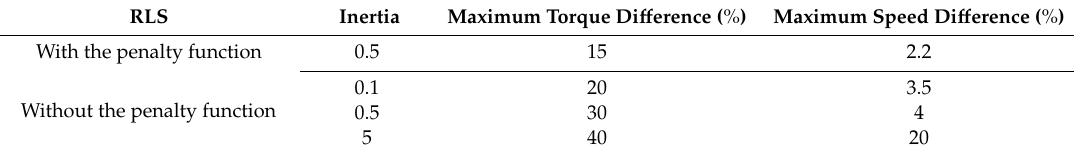
Table 2. Simulation results comparison under the New European Driving Cycle (NEDC) cycle. RLS Inertia With the penalty function Without the penalty function